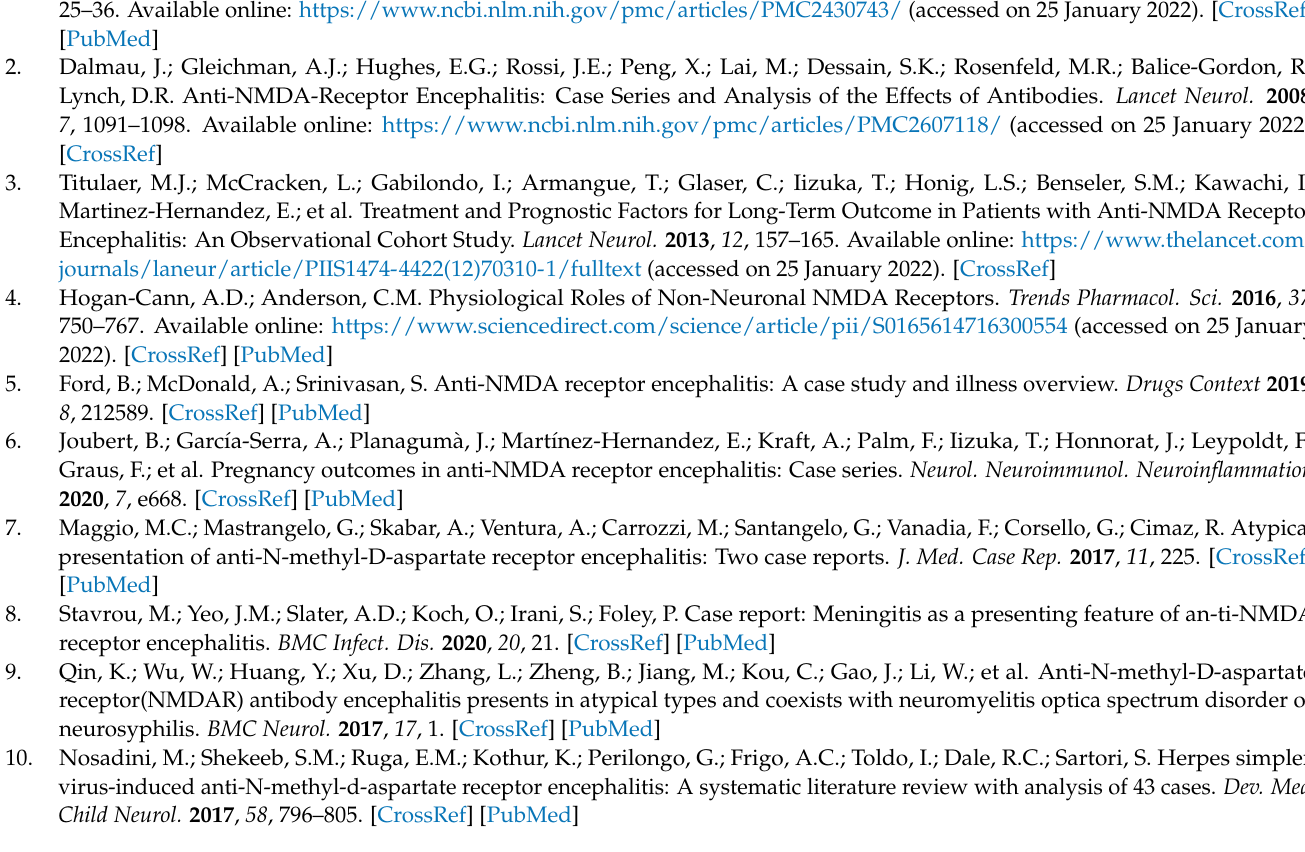
Figure S3: Follow up Thoracic radiology. Table S1: Spreadsheet with main clinical and laboratory